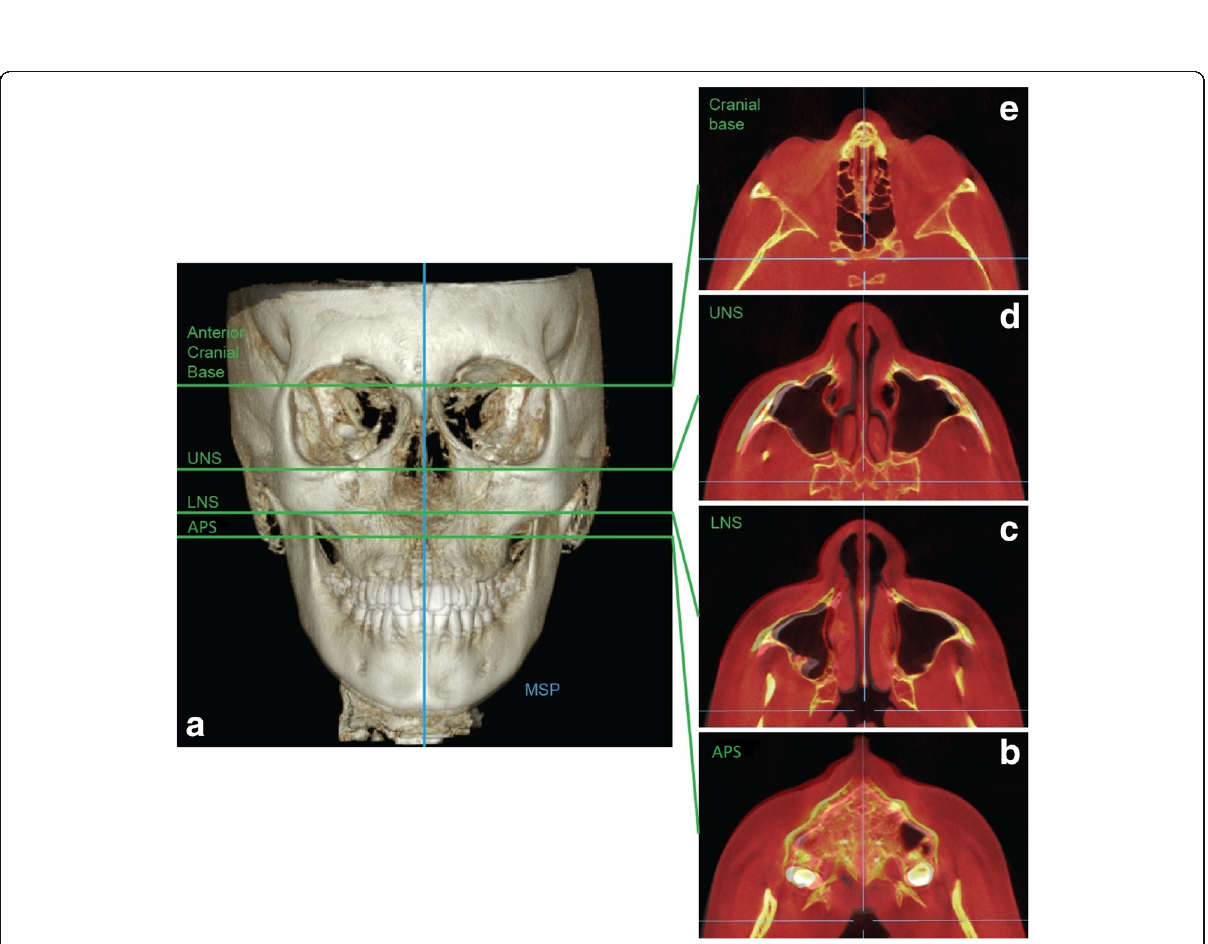
Fig. 5 Axial palatal section (APS), lower nasal section (LNS), and upper nasal section (UNS) utilized to analyze the lateral and sagittal displacement of the maxilla and pterygoid plates and the modifications along the entire length of the pterygopalatine suture. a Superimposition of pre-expansion and post-expansion 3D model on anterior cranial base. b APS, superimposed image. c LNS, superimposed image. d UNS, superimposed image. e Anterior cranial base, superimposed image. It can be noticed how bones of the maxillo-facial complex are displaced in the APS, LNS, and UNS, while no displacement takes place on anterior cranial base. For this particular patient, skeletal changes are larger on the right side of the skull rather than on the left side, in all three axial sections (APS, LNS, UNS). Facial soft tissue modifications can also be detected on the APS, LNS, and UNS. Blue lines, MSP and